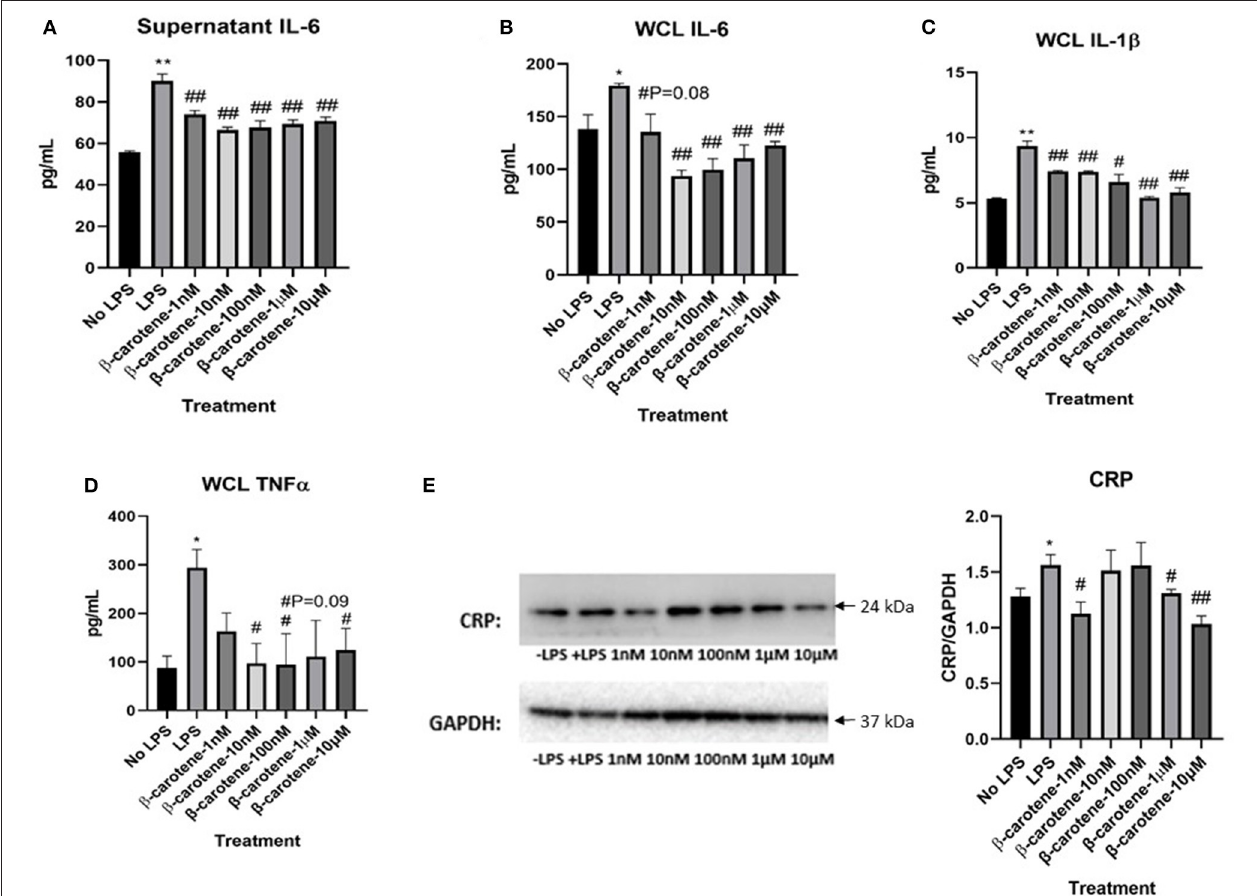
FIGURE 1 | Inhibitory effect of β -carotene on LPS-induced inflammatory markers. (A–D) Graphical representations of changes in pro-inflammatory cytokines detected via ELISA: (A) Cytokine levels of IL-6 in HT-29 cell culture supernatants; (B) IL-6 levels in HT-29 whole cell lysates (WCL); (C) IL-1 β levels in WCL; (D) TNF- α levels in WCL. (E) Western blot of CRP expression in WCL. Five treatment doses of β -carotene (1, 10, 100nM, 1, 10 µ M). Four replicates were used for statistical analysis in ELISA and western blot. Values are means ± SEMs. *Significance at p < 0.05 for comparison with the “No LPS” group, **significance at p < 0.01 for comparison with the “No LPS” group. # significance at p < 0.05 for comparison with the “LPS” group, ## significance at p < 0.01 for comparison with the “LPS”